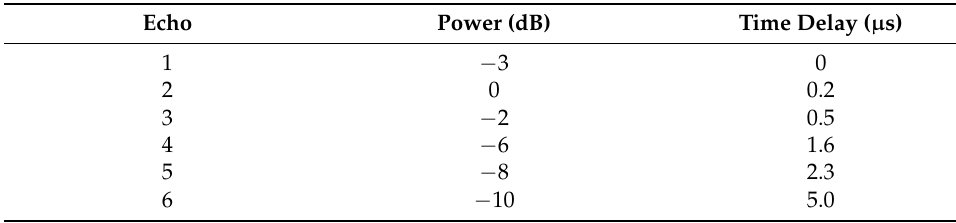
Figure 11. Scattered pilot (SP) orthogonal frequency division multiplexing (OFDM) subcarriers. Table 1. Profile of the multipath channel model.